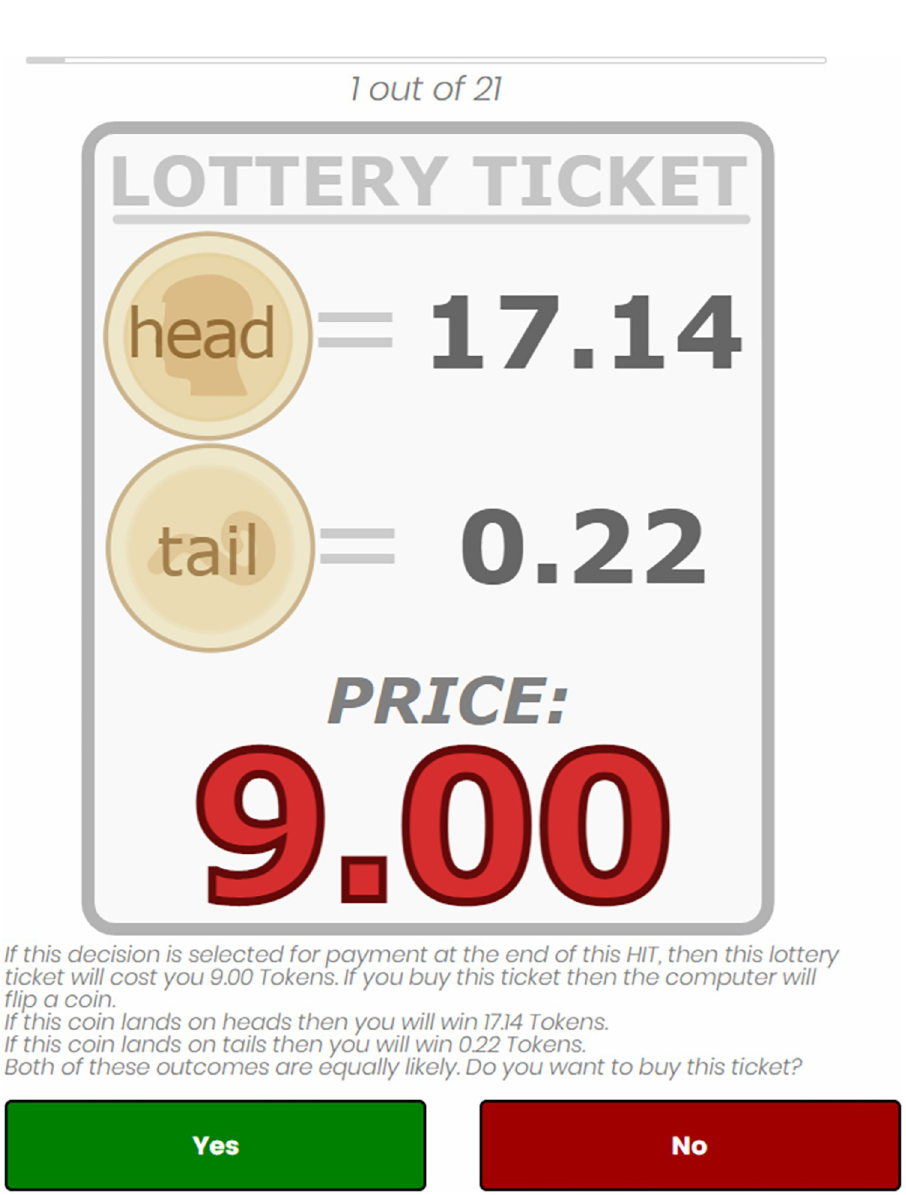
Fig 1. Example lottery ticket. Each lottery ticket had a price tag; 9.00 Token in this example. Purchasing a lottery ticket had the following two results: either the lottery ended head, then the payment was 10.00–9.00 + 17.14 = 18.14, or the lottery ended tail, and the payment was 10.00–9.00 + 0.22 = 1.22. Participants could indicate their decision by clicking on one of the two buttons below the text. All lottery tickets were presented to participants sequentially in randomized order. Only one decision was paid